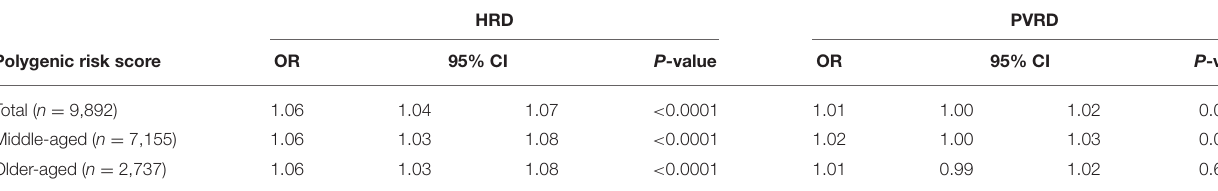
TABLE 2 | Main effect associations between PRS and CVDs.